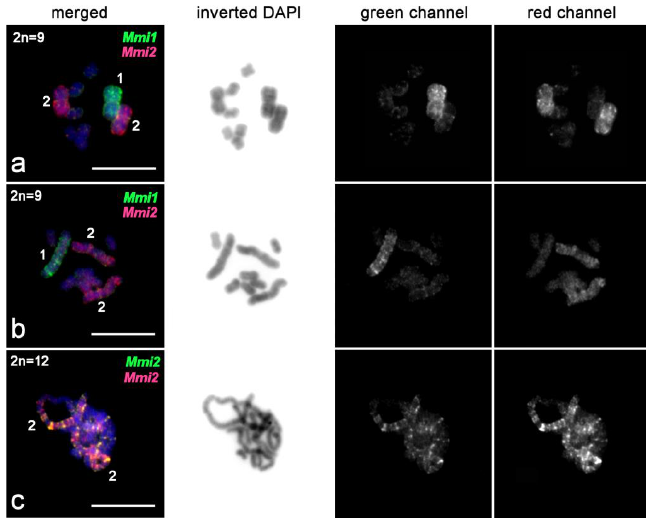
Figure 8. Chromosome painting with single-copy DNA probes on chromosomes of M. mirumnovem . ( a , b ) FISH with DNA probes derived from chromosomes 1 (green signal) and 2 (red signal); ( c ) FISH with two DNA probes derived from different homologs of MMI2 (green and red signals). Chromosomes were counterstained with DAPI (blue). Scale bar 10 µm . FISH with the Mmi3 , Mmi4 , and Mmi5 DNA probes painted the original chromosomes evenly and additionally provided signals of lower intensity in regions of the large chromosomes MMI1 and MMI2 (Figure 9). These DNA probes provided different painting patterns on the large chromosomes. Mmi4 painted mostly one arm in both MMI1 and MMI2 (Figure 9b), a little more intensively in MMI2 than MMI1 (Figure 9b). FISH with the Mmi3 and Mmi5 DNA probes painted small alternating regions in both large chromosomes (Figure 9d, Table S2). It is not easy to differentiate between FISH signals coming from regions enriched with repeat clusters compared to ordinary euchromatic regions, but a comparison of chromosomes of different condensation levels allows us to suggest that DNA probes derived from MMI3 – MMI5 usually did not intensively paint the regions enriched with repetitive DNA (Figure 9c). In addition, based on FISH results obtained with the Mmi3 , Mmi4 , and Mmi5 DNA probes, we could not differentiate small paralogous euchromatic regions and regions enriched with repetitive DNA in the MMI1 and MMI2 chromosomes. Taking the FISH results with all DNA probes together, we can describe only the distribution of small regions that were marked by the FISH signals from different DNA probes (Table S2). In addition to the pericentromeric regions, the repeat-enriched regions were distributed mostly along large chromosomes, and many of them were chromosome-specific. Two-color FISH with single-copy chromosome-specific DNA probes derived from two homologs of MMI2 showed that copy number variation of DNA repeats in various copies of chromosome MMI2 could be present (Figure 8c).